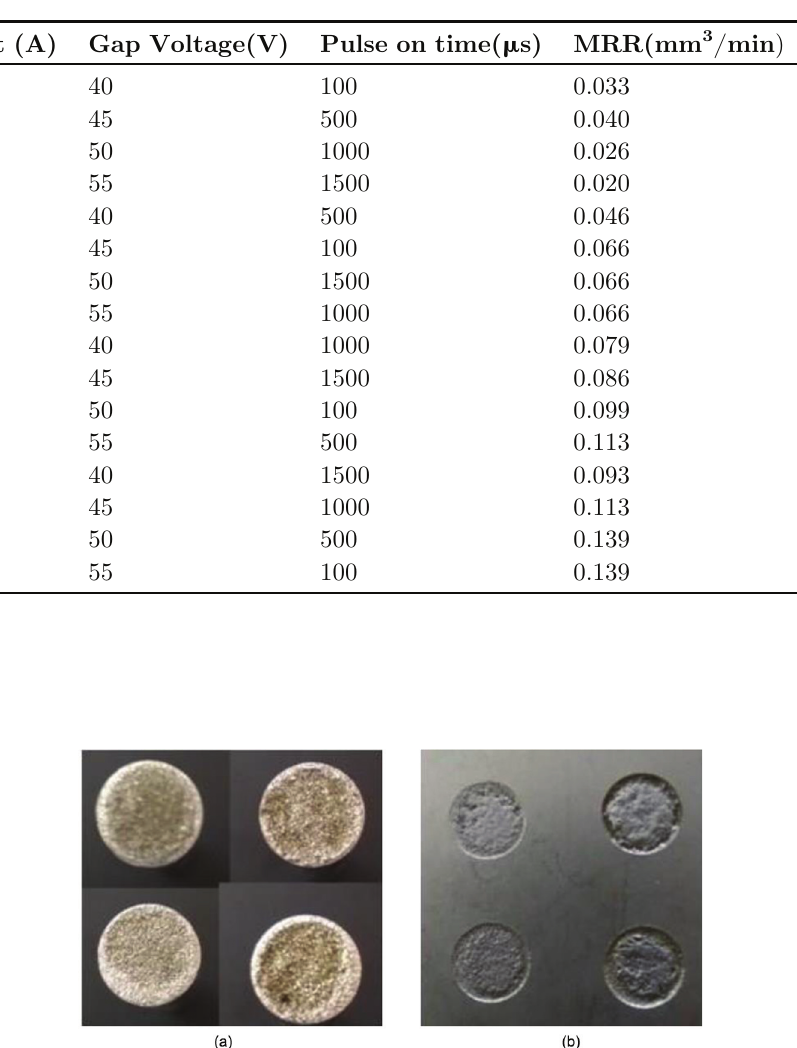
Table 3. Experimental results.